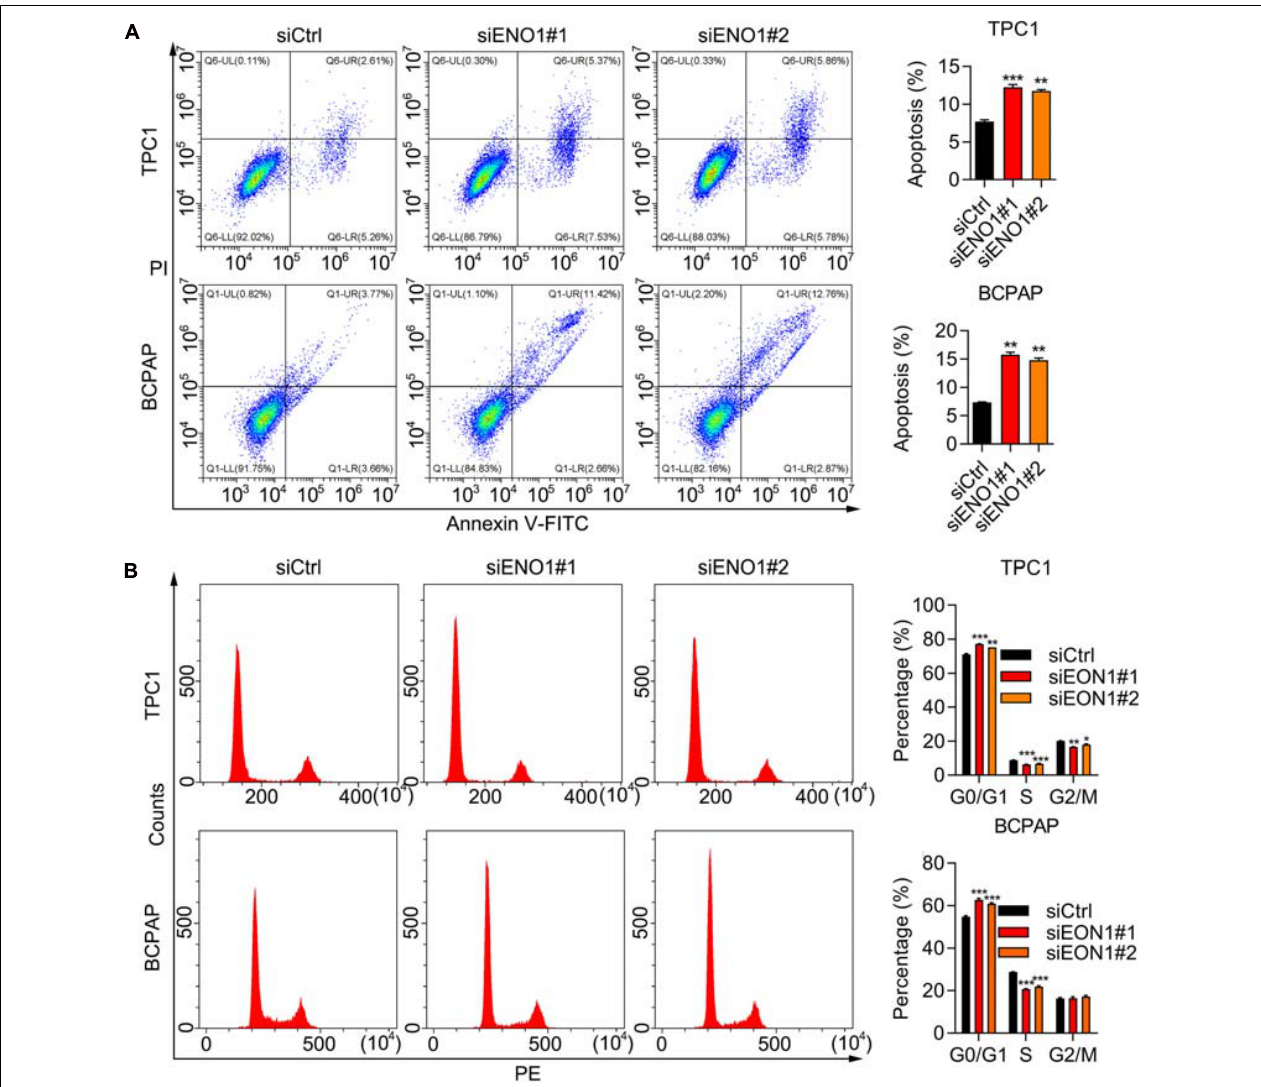
FIGURE 3 | ENO1 regulates cell cycle and apoptosis. (A) Cell cycle analysis using PI staining and flow cytometry in siCtrl, siENO1#1, and siENO1#2 transfected into TPC1 and BCPAP cells. ** P < 0.01, *** P < 0.001. (B) Flow cytometry analysis of apoptosis using annexin V-FITC and PI staining in TPC1 and BCPAP cells transfected with siCtrl, siENO1#1, and siENO1#2. *** P < 0.001, ** P < 0.01, * p <